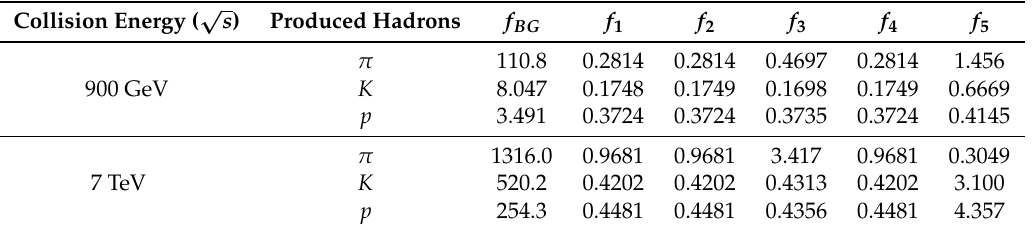
Figure 1. The p T spectra for pions (upper) and kaons (lower) in pp collisions at 7 TeV at midrapidity as examples. Data are taken from [16,17]. All are fitted with all of the functions of Equation (3) in the ranges of 0.1 < p T < 2.6 GeV at respectively. Ratios of the net fits to data are also shown in the lower panel. The relevant values of χ 2 / d . o . f . are shown in Table 1. Table 1. The values of χ 2 / d . o . f . of spectral fits for pions, kaons, and protons in pp collisions at 900 GeV and 7 TeV as